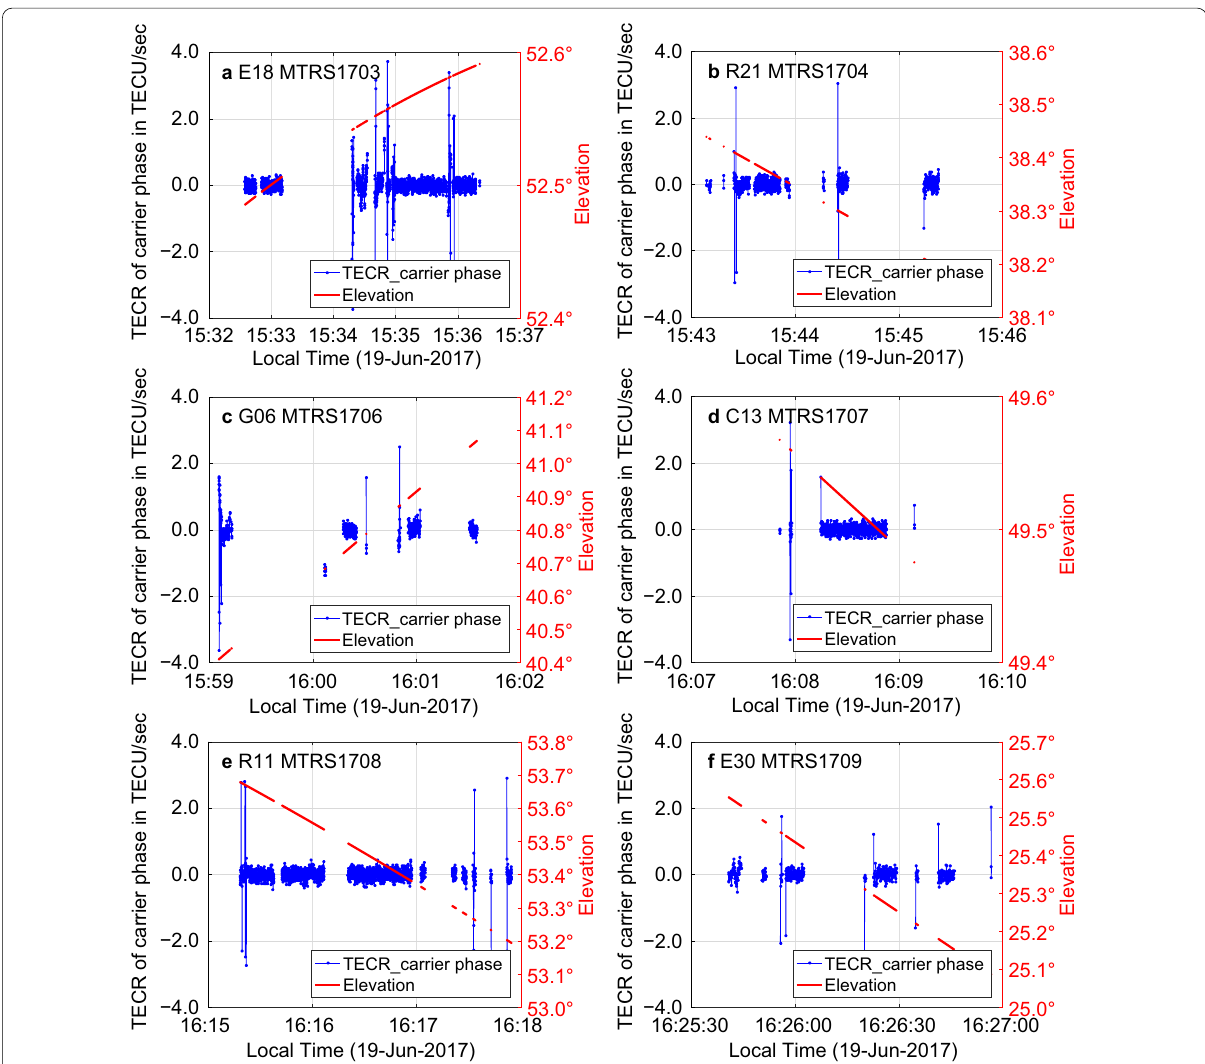
Fig. 8 TECR derived from six different satellites with the corresponding satellite elevations. The results are presented in ( a – f ). The time format is HH:MM (or HH:MM:SS because of different time